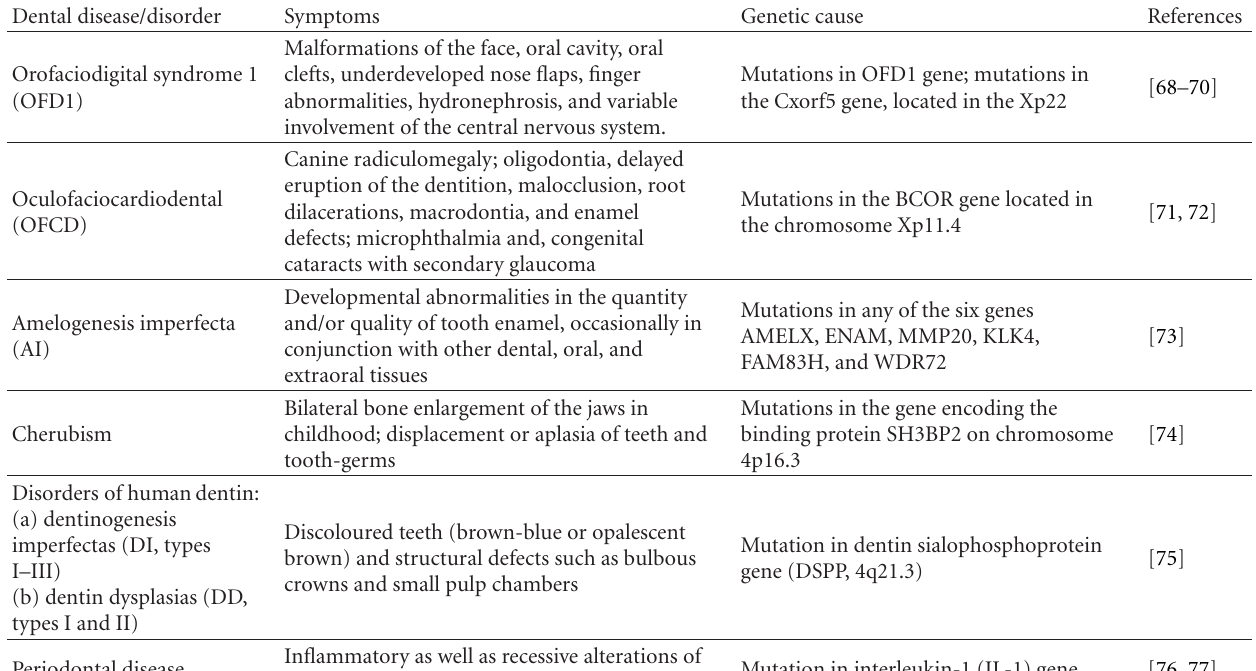
Table 2: Human genetic oral diseases/disorders causing dental